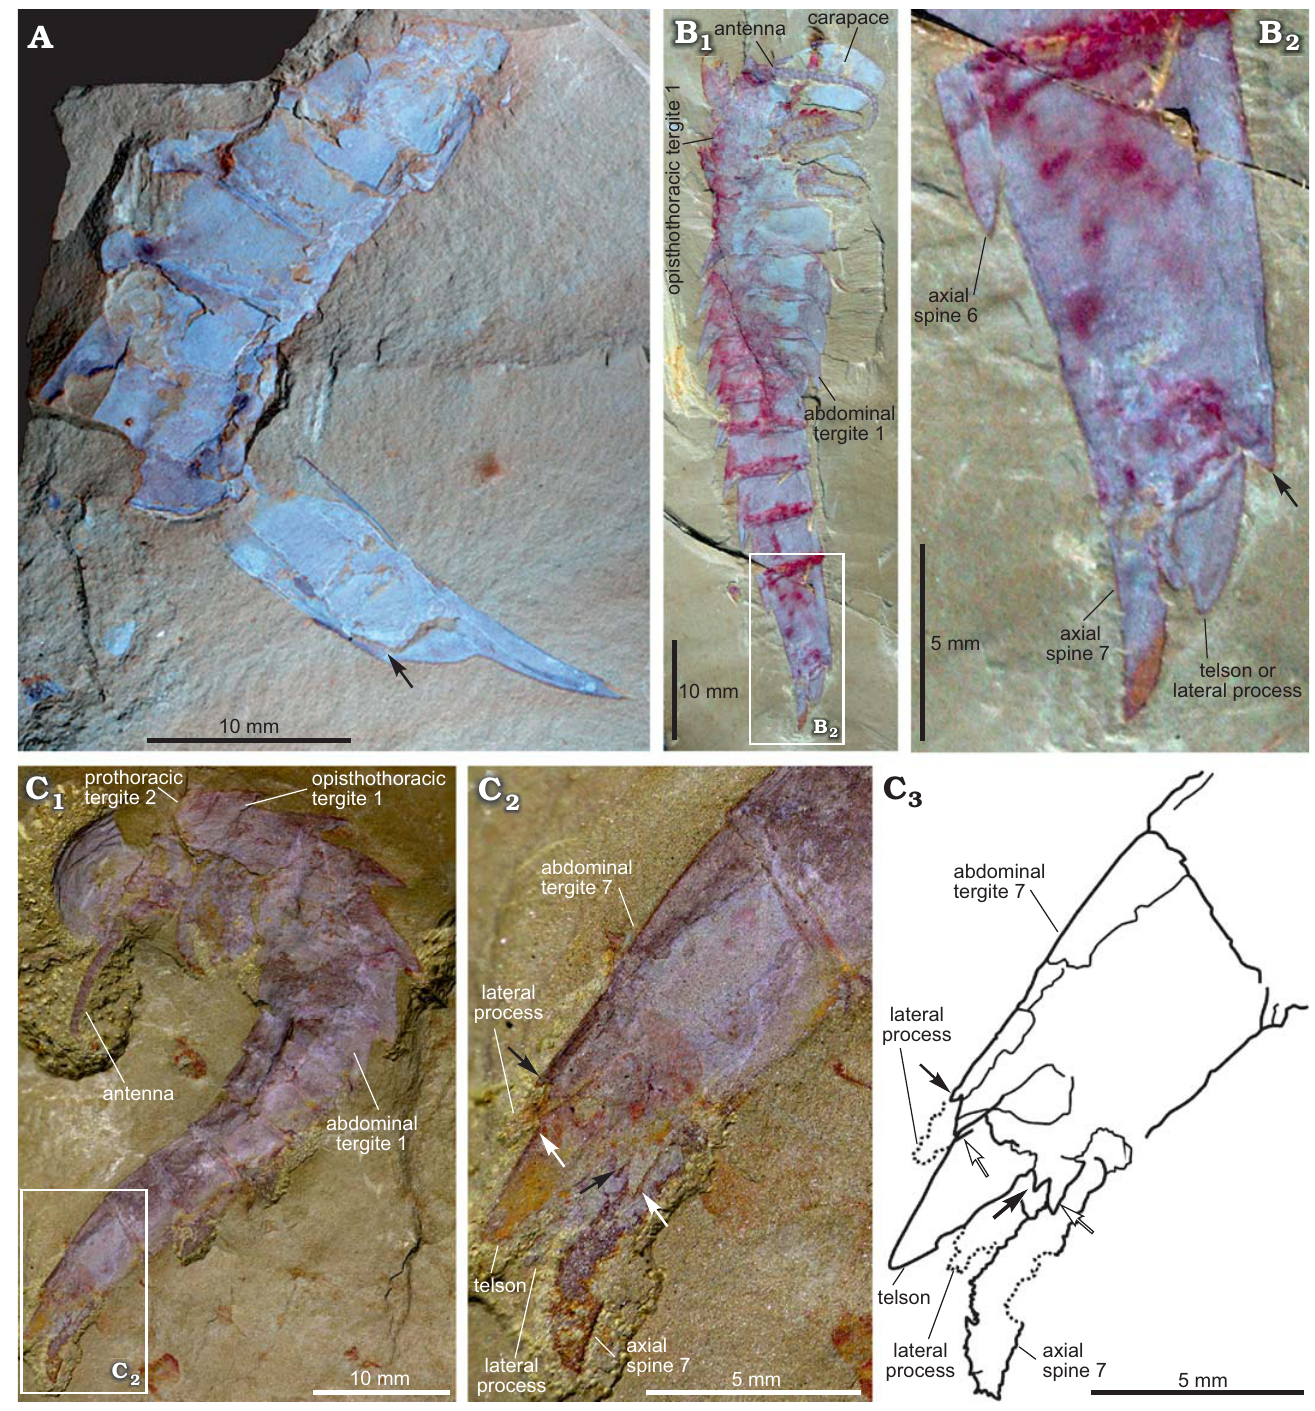
Fig. 2. Terminal abdominal tergite and associated structures of fuxianhuiid arthropod Guangweicaris spinatus Luo, Fu, and Hu, 2007 from the lower Cambrian Guanshan Biota, China. A . YIGS Kgs-1-62 (paratype), incomplete abdomen in lateral view. B . NIGPAS Kgs-1-137, nearly complete specimen in lateral view (B 1 ), close-up (B 2 ). Arrows indicate the position of the posteroventral spine. C . YKLP 11566, complete trunk and telson in lateral view (C 1 ), close-up (C 2 ), explanatory drawing (C 3 ) , white arrows, outer spines; black arrows, inner spines. Image B courtesy of Shixue Hu (Chengdu Centre of the Geological Survey of China, Chengdu,